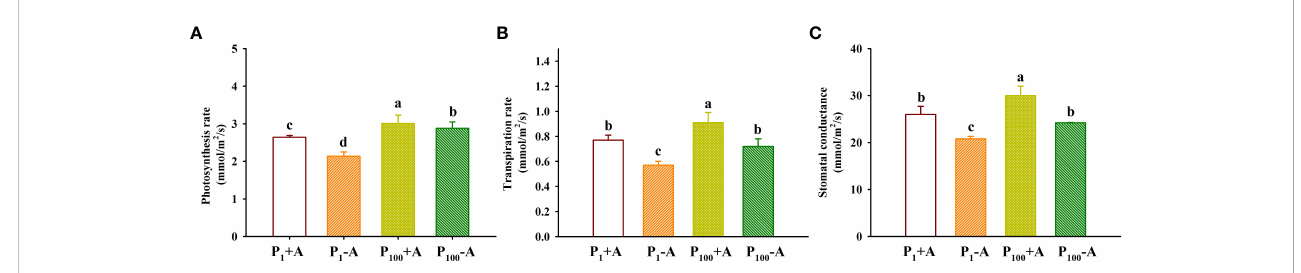
FIGURE 4 Changes in leaf photosynthesis rate (A) , transpiration rate (B) , and stomatal conductance (C) of walnut seedlings inoculated with Diversispora spurca grown in 1 and 100 m mol/L phosphorus levels. Data (means ± SD, n = 4) followed by different letters above the bars indicate signi fi cant ( P < 0.05) differences. The abbreviations were shown in Figure 1.